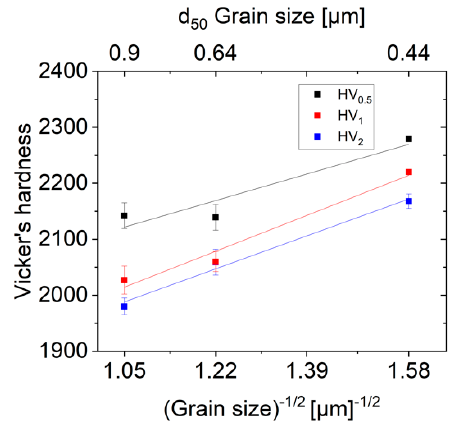
Figure 6. Influence of the alumina grain size on the hardness of the sample.